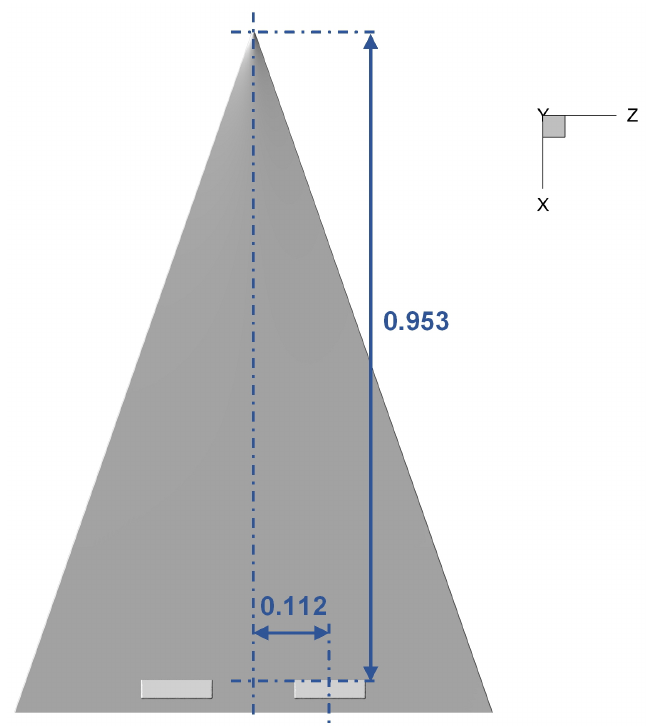
Figure 2. Mechanical Control Surface (with 30° downward